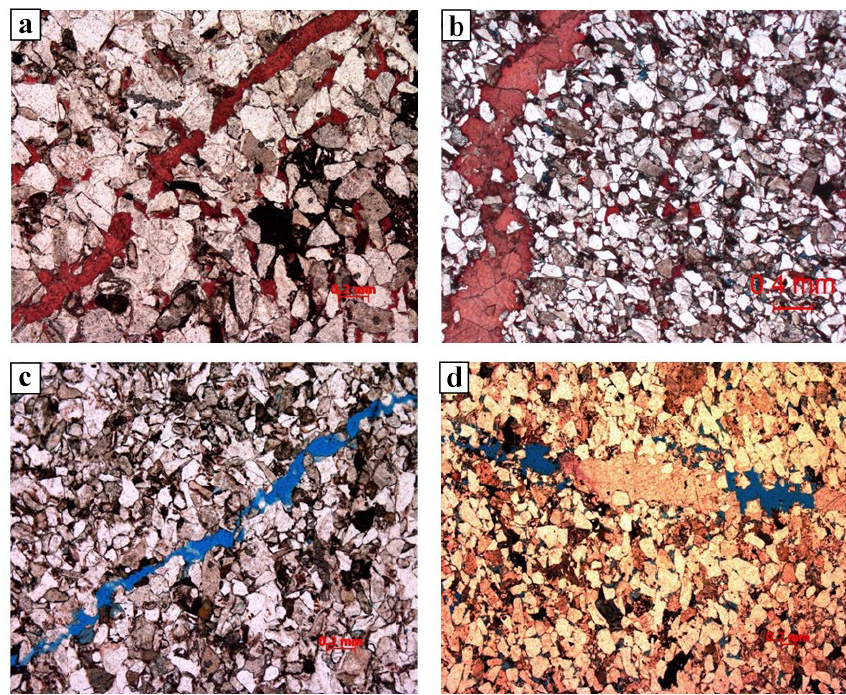
Figure 11. Thin sections showing the cementation and dissolution along the fracture surfaces of Cretaceous Bashijiqike Formation in Kuqa Depression (Xin et al., 2022). (a) Calcite cementation along fracture surface, Keshen 242, 6567.51m, K 1 bs. (b) Calcite cementation along fracture surface, Bozi 22, 6323.64m, K 1 bs. (c) Dissolution along fracture plane, Keshen 242, 6568.95m. (d) Coexistence of cementation and dissolution along fracture surfaces, KS 242,